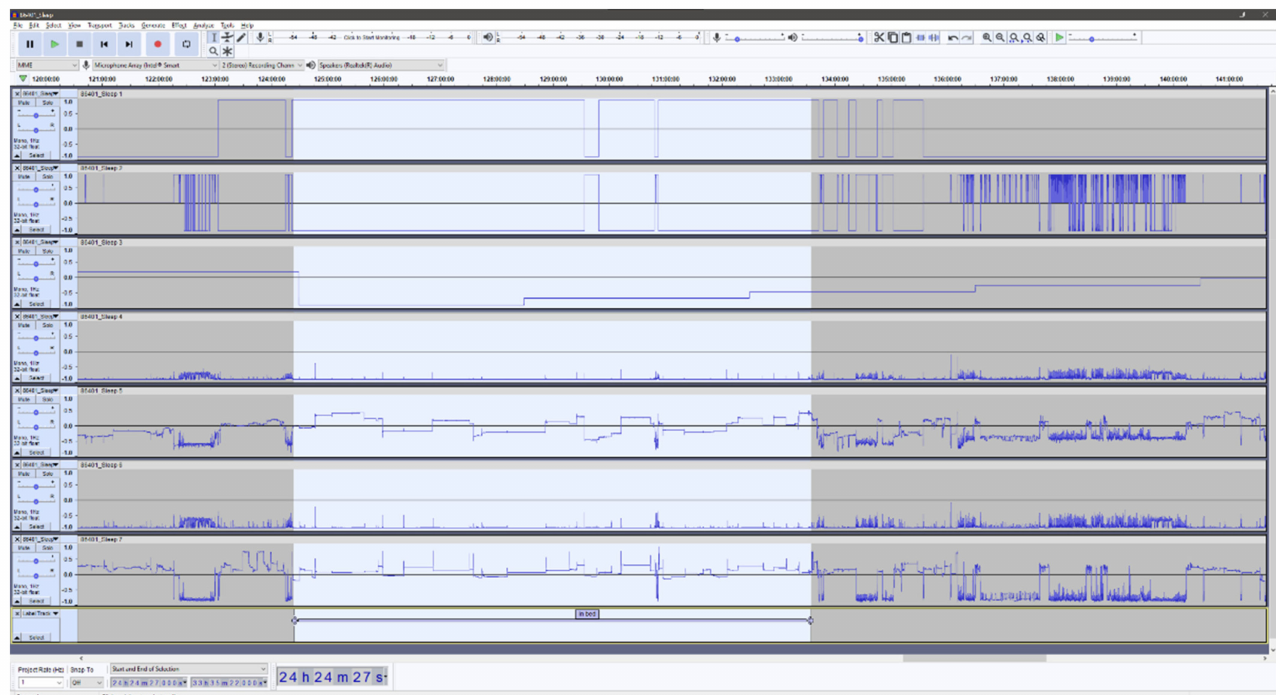
Figure 2. Screenshot of the Audacity interface when zoomed in on a single night for the labeling of the in-bed period. The seven horizontal panels represent the included signal features. See Table 1 for a detailed description of